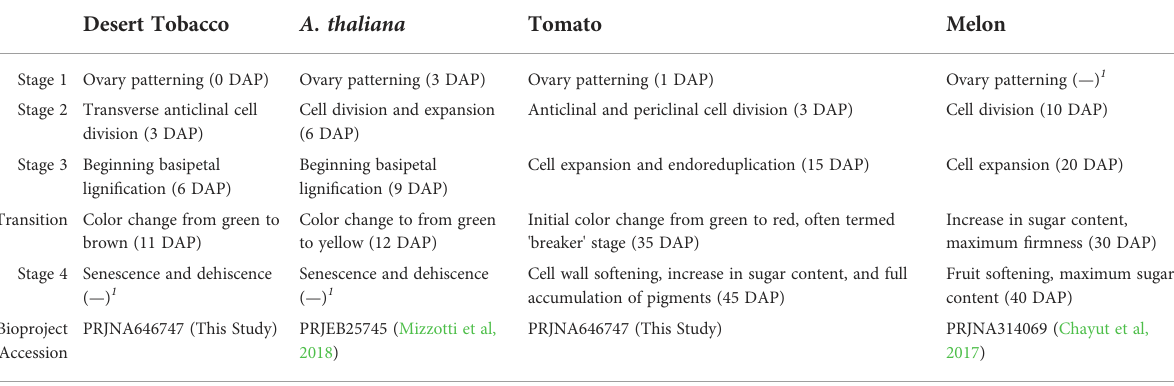
TABLE 1 Developmental stages of fruit development in the study species and data